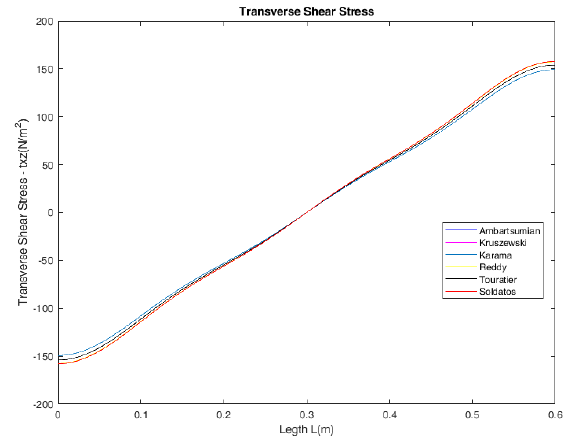
Figure 7. Comparison of transverse shear stress τ xz through the length of the beam at ( x , z = h /4 ) for all models with aspect ratio S = 30.